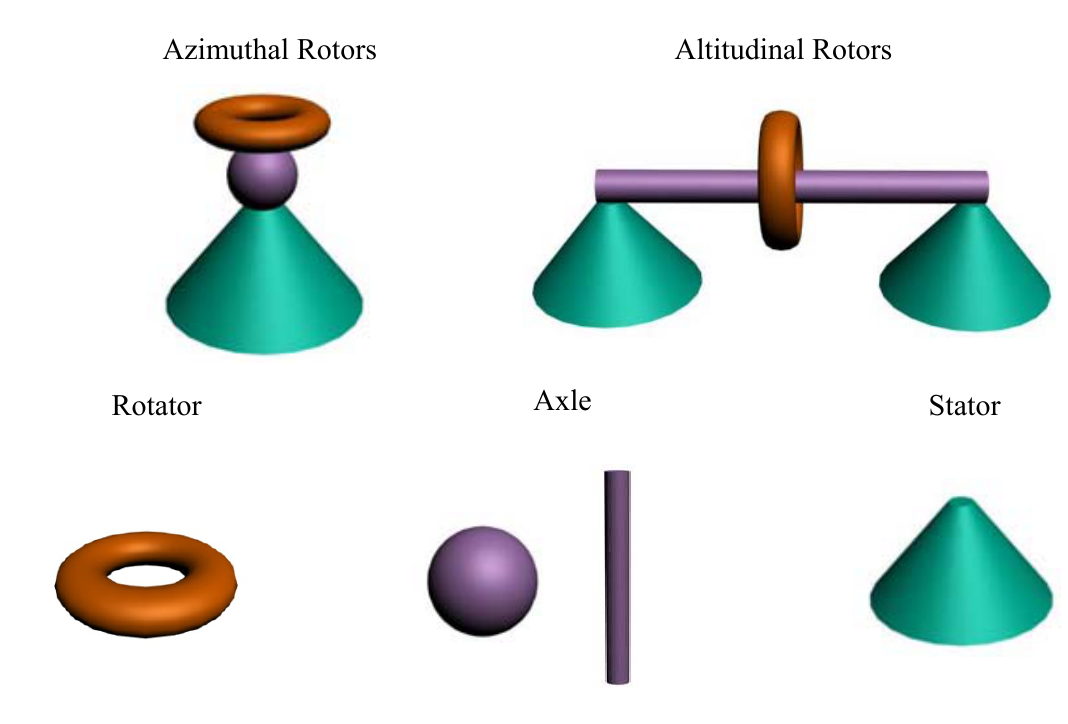
Figure 1. Classification for surface mounted molecular rotors showing azimuthal and altitudinal rotors. Each component make up the rotor is shown